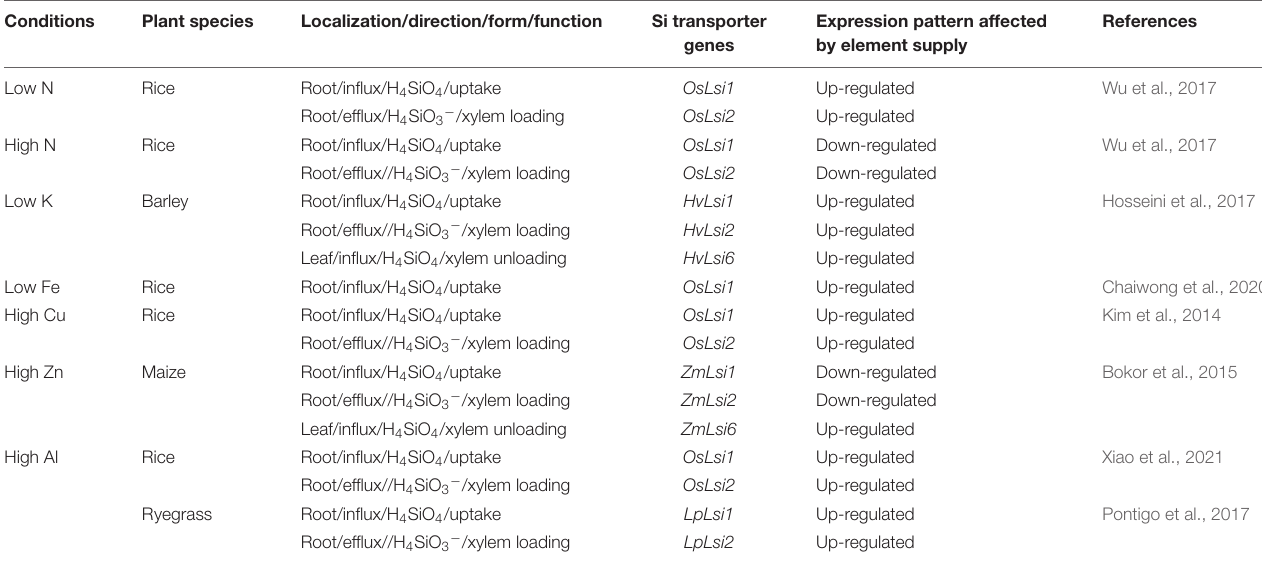
TABLE 2 | Evidence for expression of Si transporter genes affected by supply of essential and beneficial elements.